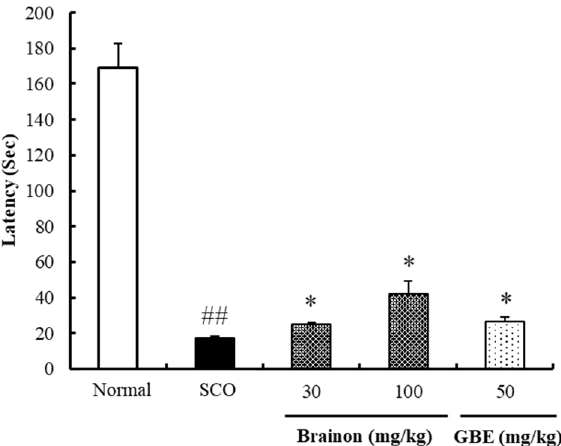
Figure 2. Effects of Brainon scopolamine-treated memory deficit in passive avoidance performance. Values are represented as means ± SEM ( n = 8). ## p < 0.01 vs. Normal group; * p < 0.05 vs. SCO-treated group.